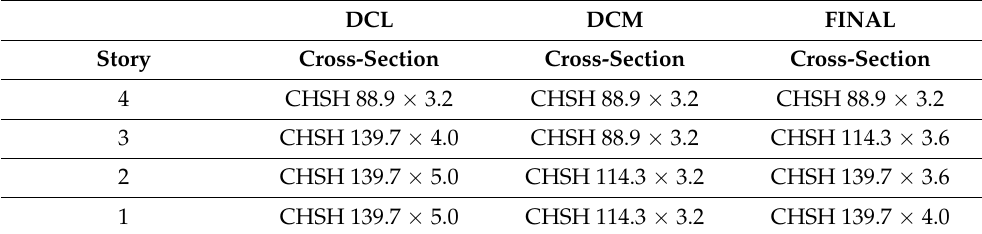
Figure 16. FINAL: NC shear force D / C ratios on columns (pushover analysis). Table 6. Comparison between the cross-sections of the designed retrofitting